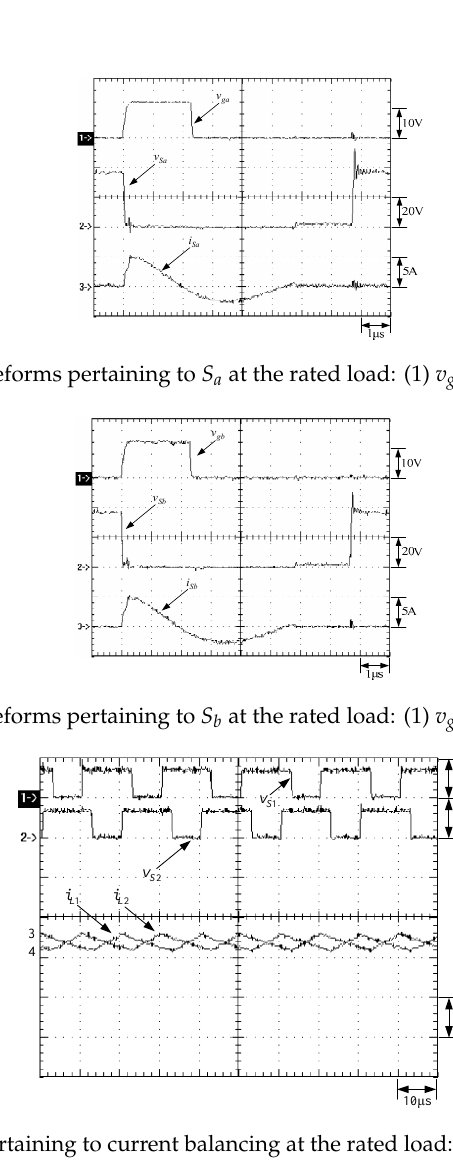
Table 2. Comparisons between the circuits from [37], [47] and the proposed circuits (ZVS: zero- voltage switching; ZVT: zero-voltage transition; ZCS: zero-current switching; ZCT: zero-current transition). Comparisons Resonant Count